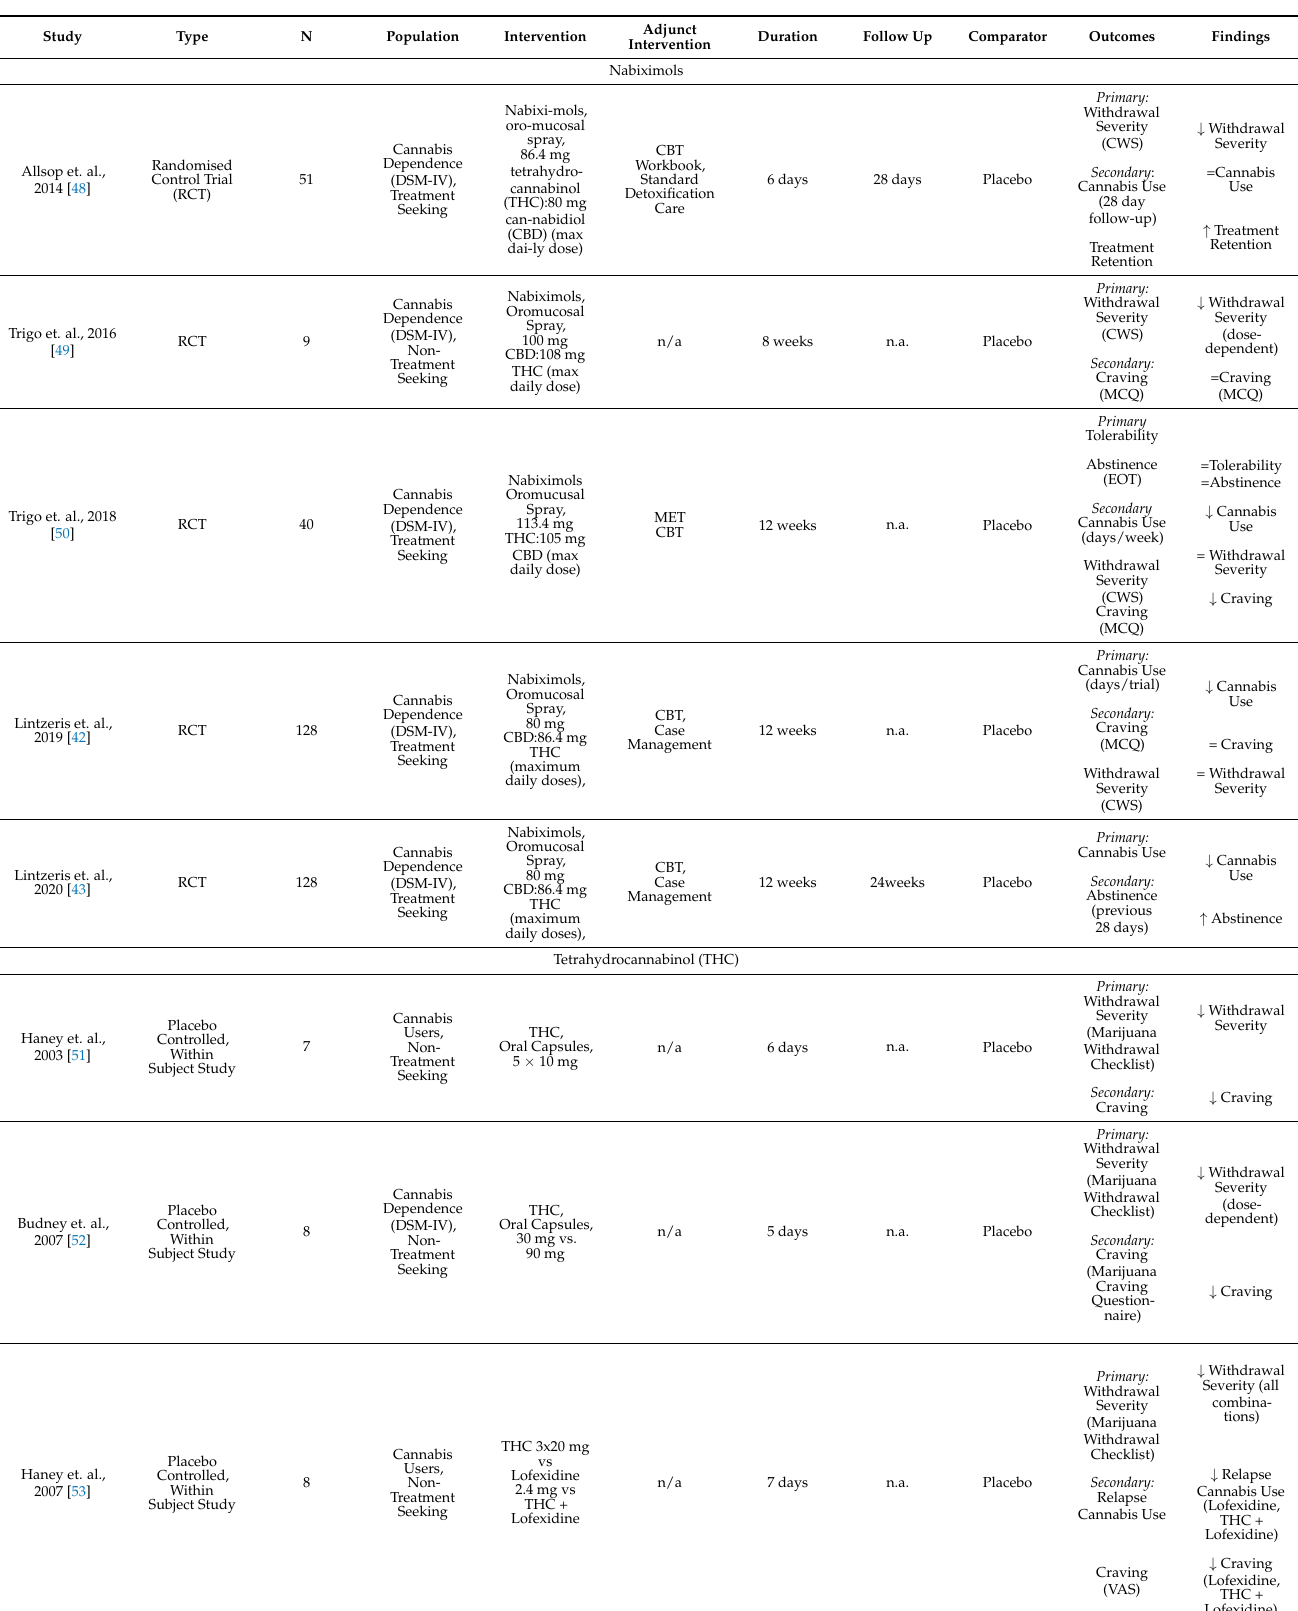
Table 3. Primary Studies pertaining to Cannabis Use